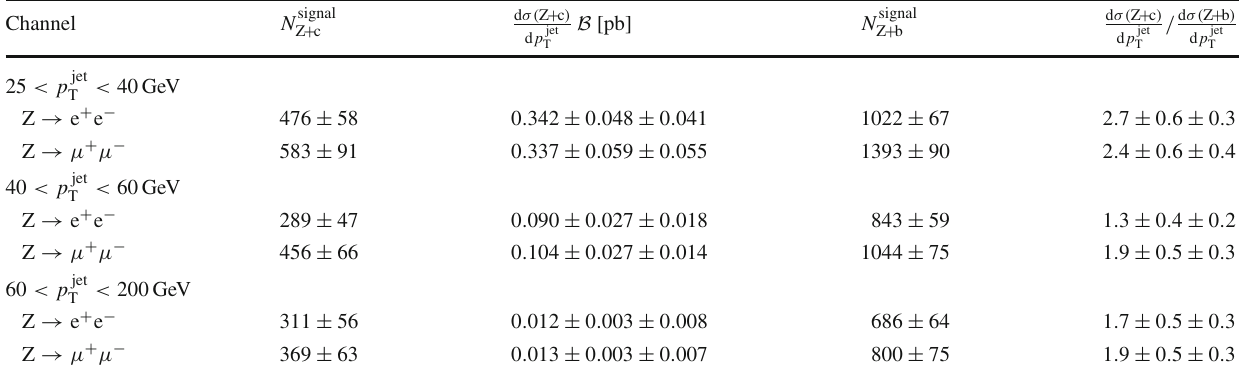
Table 3 Differential cross section d σ( Z + c )/ d p jet and in the two Z boson decay channels. The N signal yields of Z + c and Z + b events, respectively, extracted from the fit. All